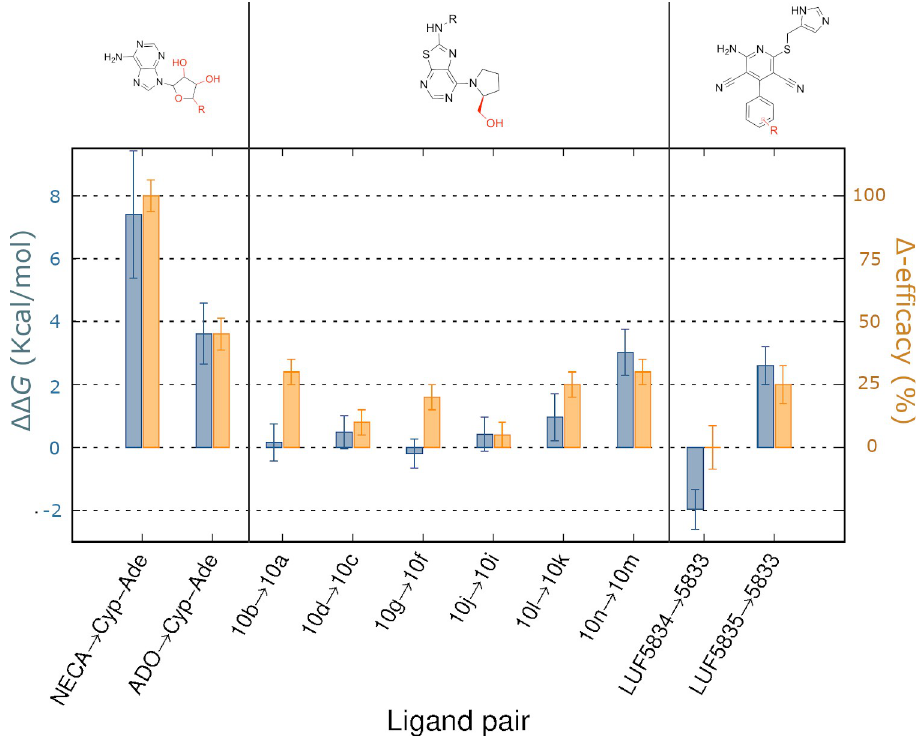
Fig 4. Calculated relative affinities for the active vs inactive receptor conformation. Relative affinities expressed as ΔΔ G = Δ G b,R � - Δ G b,R (kcal/mol, blue bars, average values ± SEM) for pairs of agonists/antagonist of analogous chemotype (depicted in the top, with the chemical groups varied along the FEP simulations in red). For each ligand pair, the relative shift in experimental efficacy is shown as Δ -efficacy (orange bars, E max,ago -E max,antago , in % ± SEM), with corresponding Emax values reported relative to the reference full agonists NECA [28], or CGS21680 -for the LUF chemotype [29], see